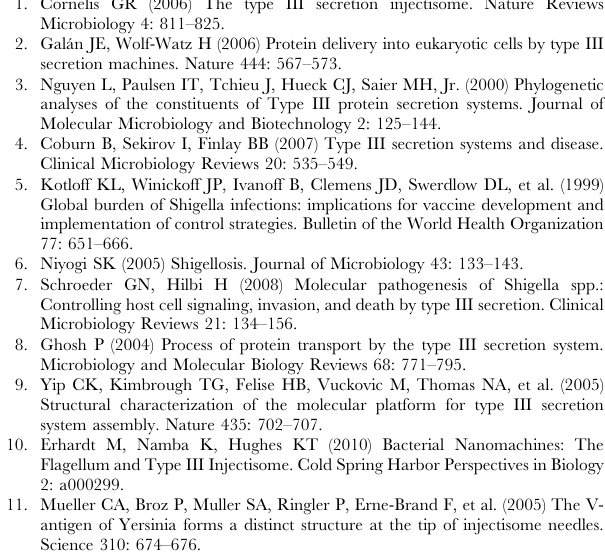
Subunits per turn Axial rise per monomer/A˚ Needle